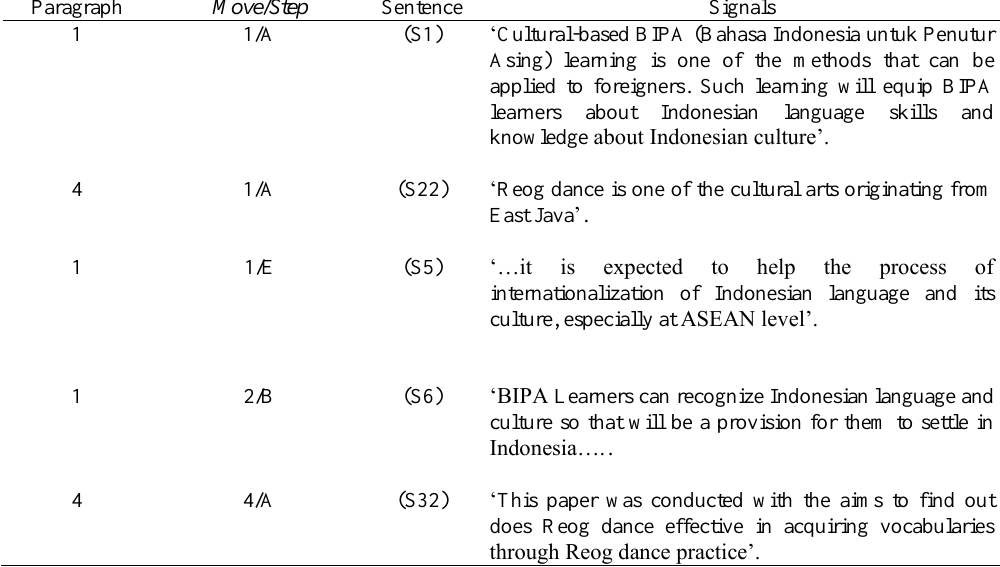
Move and Step in research article introduction in research article